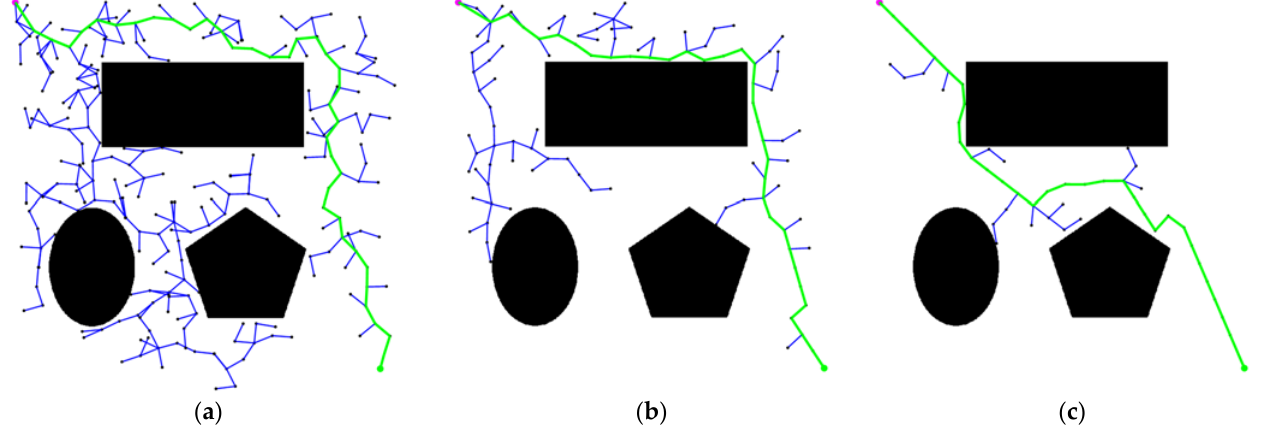
Figure 6. The obstacle avoidance path planning result of scenario A ( a ) RRT; ( b ) G_RRT; ( c ) GA_RRT.